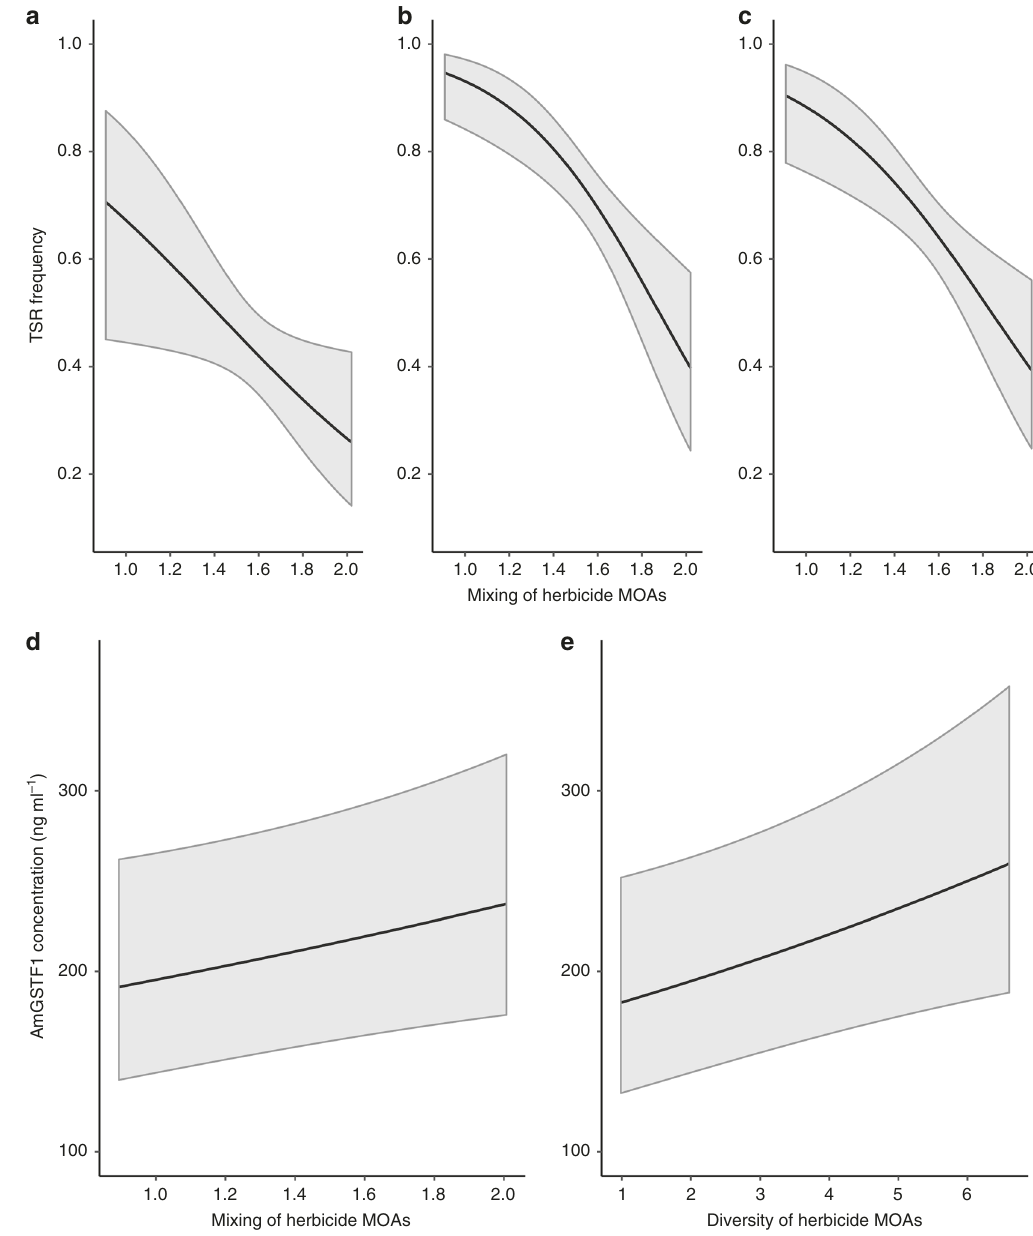
Fig. 4 The effect of historical herbicide mixing and diversity on selection for target-site (TSR) and non-target-site resistance (NTSR) mechanisms. a – c show the mean predicted relationship between herbicide mixing and TSR frequency for the SU ( p = 0.023), Fop ( p ≤ 0.001) and Dim ( p = 0.002) herbicides, respectively. Coef fi cients are from mixed model analyses fi tted for each TSR separately (Supplementary Table 4). d The mean predicted relationship between the use of herbicide mode of action mixtures and the foliar concentration of Am GSTF1 ( p = 0.040) (used here as a proxy for NTSR), and e the mean predicted relationship between the overall diversity of herbicide modes of action and the foliar Am GSTF1 concentration ( p ≤ 0.001) following mixed model analysis are given in Supplementary Table 3. Solid lines show the mean predicted relationship, with shaded regions representing the 95% con fi dence interval of the subsequently generated by combining 50% by weight of seed collected at all sampling locations within a fi eld. These fi eld-scale seed populations were used in all phenotypic and genotypic assays reported here. Blackgrass abundance in each fi eld was visually recorded using a density-structured approach 55 , and with a density calculated per fi eld on a scale of 0 – 4 (absent – very high).